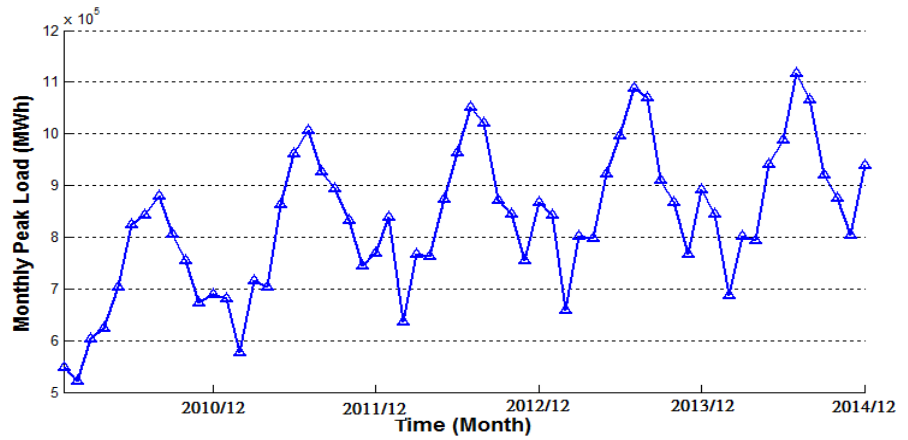
Figure 3. The load time series from January 2009 to December 2013.